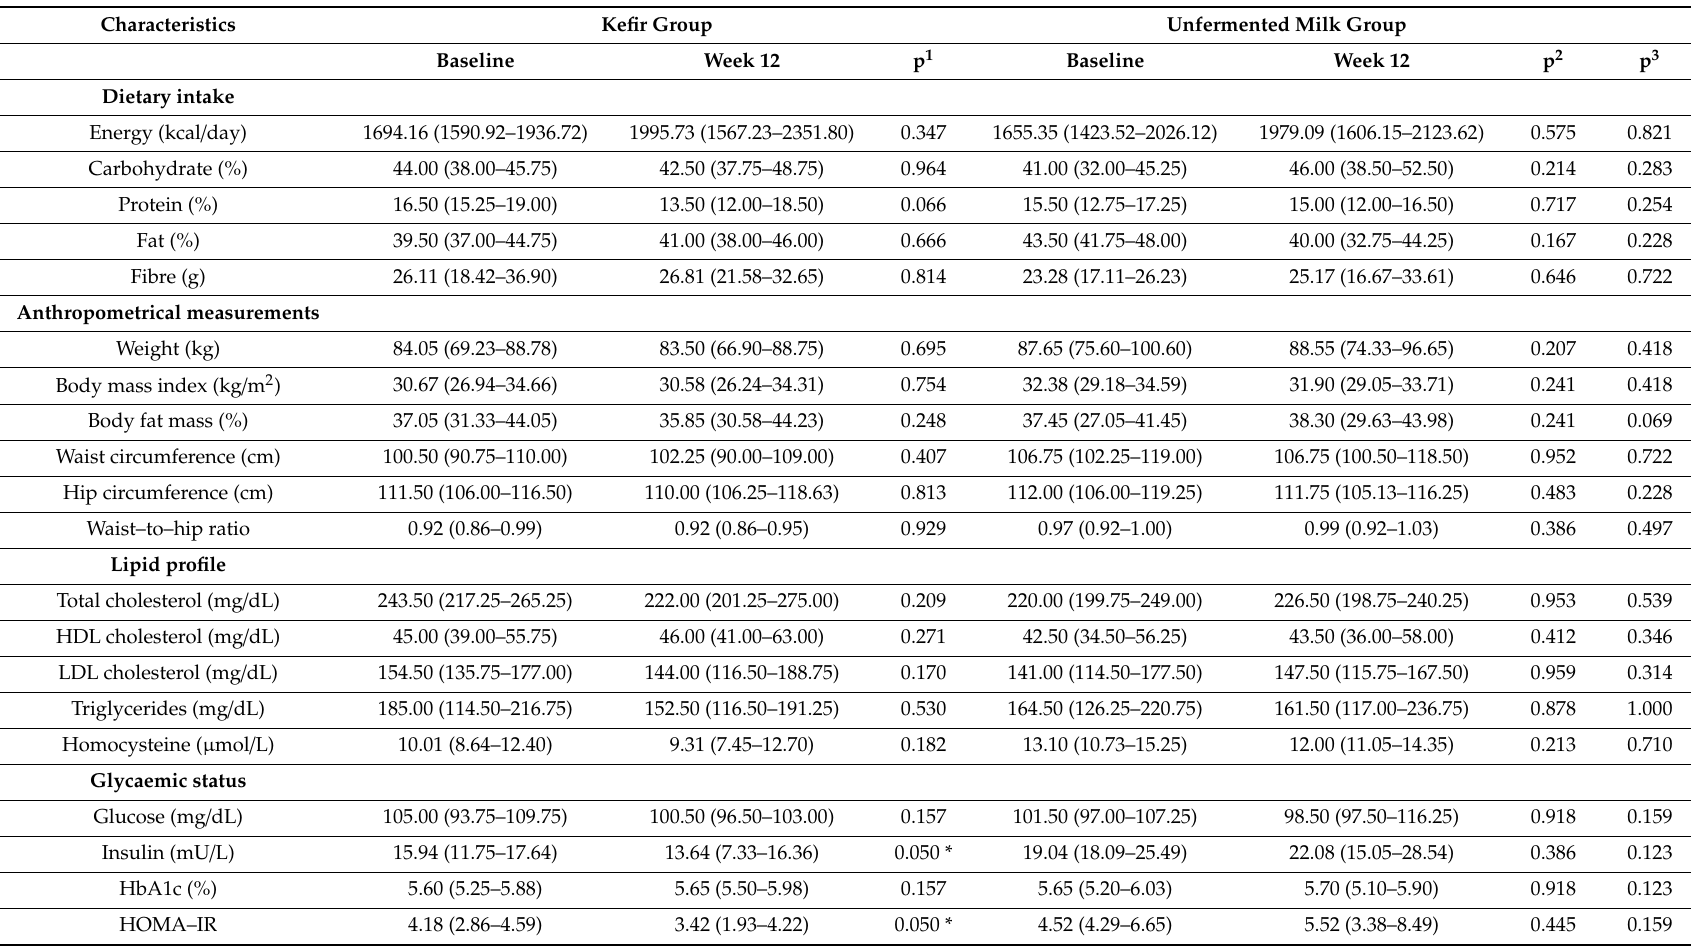
Table 2. Dietary intake, anthropometrical measurements, biochemical parameters, and blood pressure in kefir and unfermented milk